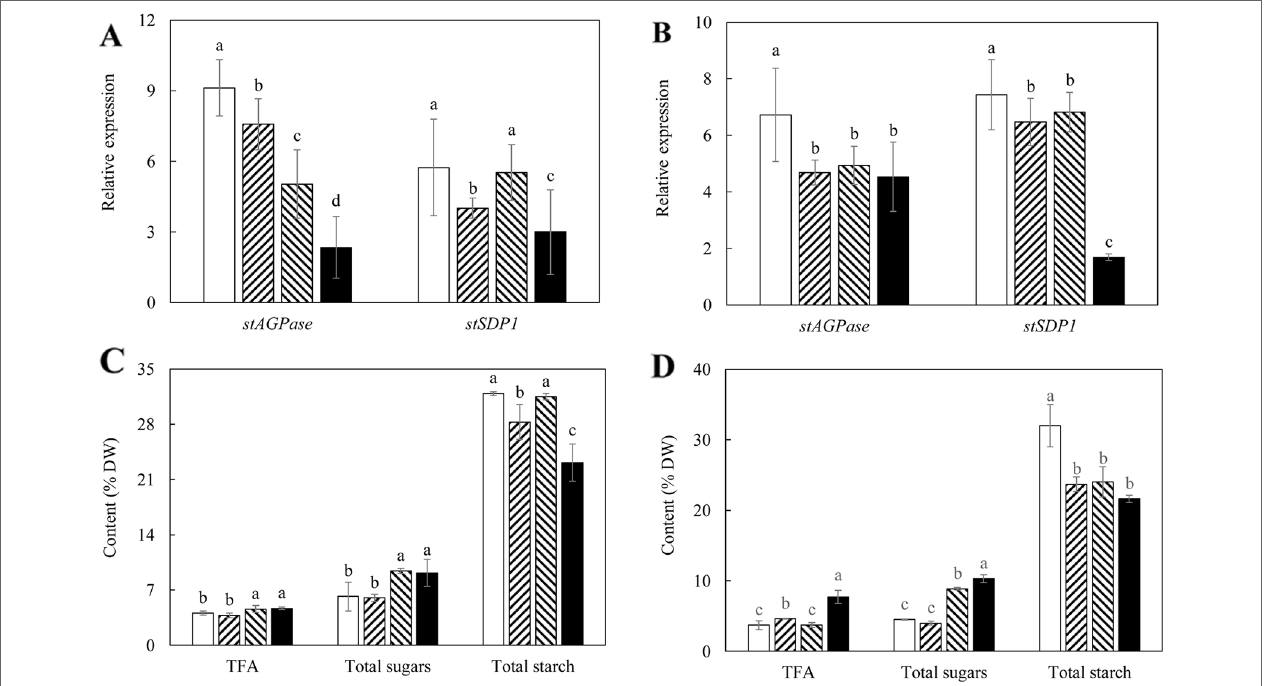
FigURE 5 | Gene expression analysis and total carbon allocation in the potato tubers of the HO69 (open bars) and three super-transformed lines, 69-L1 (bar with upward trend), 69-L2 (hatched bars) and 69-L3 (black bars) at two developmental stages. (A) Real-time quantitative reverse transcription polymerase chain reaction (qRT-PCR) result at the flowering stage; (B) Real-time qRT-PCR result at the mature stage; (c) Total carbon allocation at the flowering stage; (D) Total carbon allocation at the mature stage. The data represent the mean values ± SD of three biological replicates. Letters (a, b, c) above the bars are based on LSD, bars marked with different letters are statistically significantly different at P <